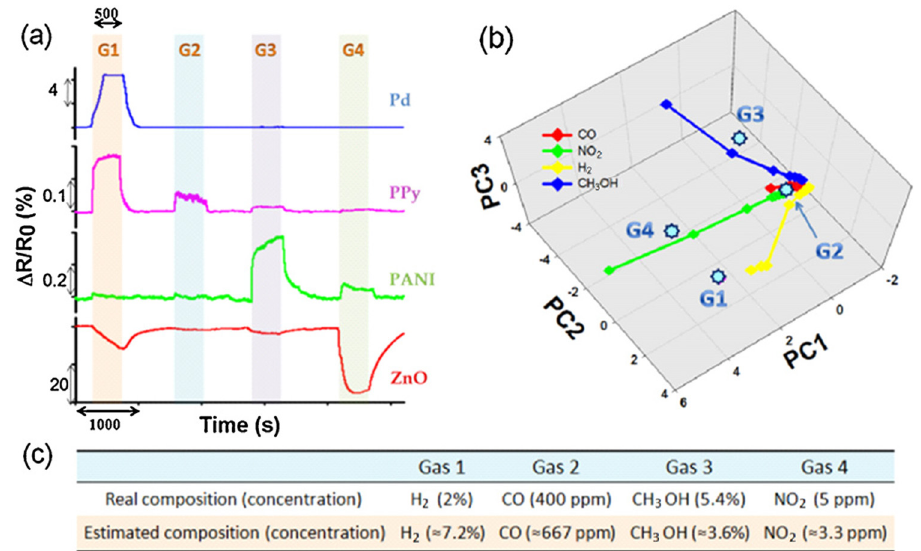
Figure 5: Real - time sensing signals and the corresponding PCA plot. ( a ) Dynamic percentage response ( change in resistance divided by the base resistance ) collected from the four sensors during four response – recovery cycles. ( b ) 3D PCA plot including training points ( colored points connected by lines ) and test points ( four teal octagons labeled G1 – G4 ) ; ( c ) comparison between the real gases injected and the estimates from the sensing system. Modi fi ed with permission from ref. [ 32 ] .